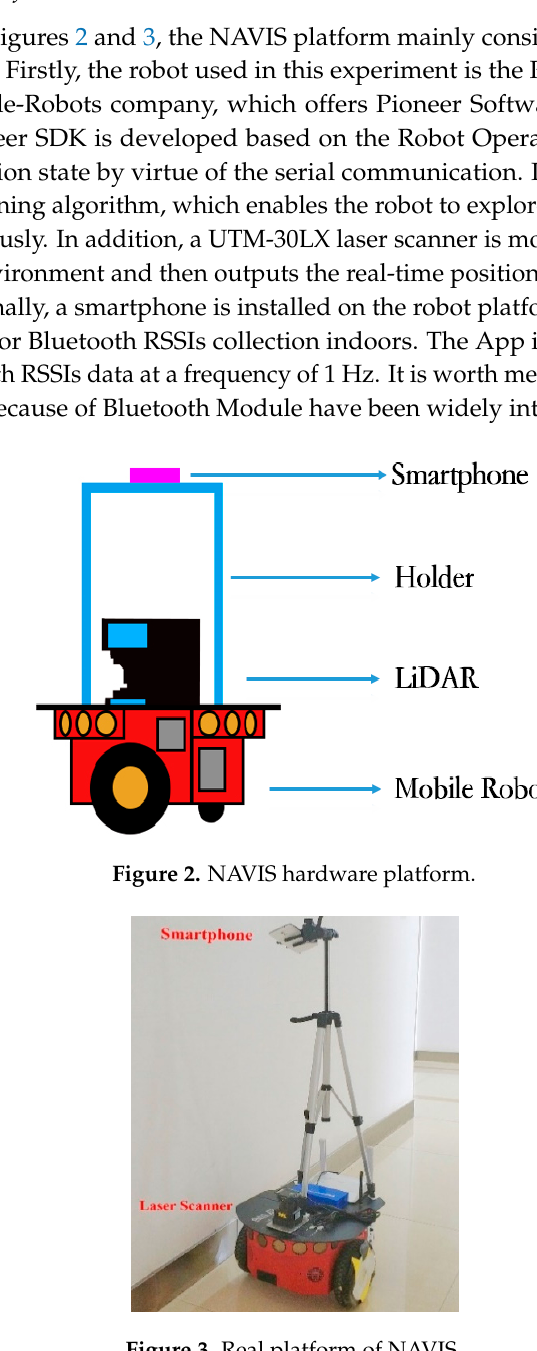
Figure 3. Real platform of NAVIS.